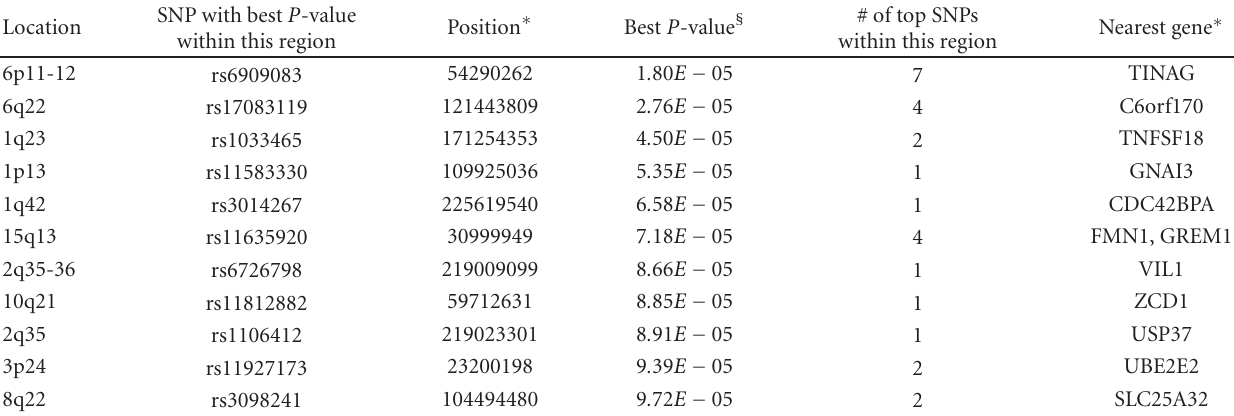
Table 3: Regions with strongest imputation-inferred associations ( P < . 0001) using estimated allelic dosage under an adjusted additive genetic